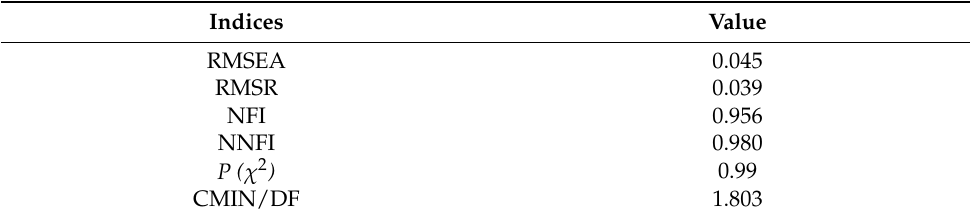
Table 7. Internal consistency of the CEFI-R questionnaire.